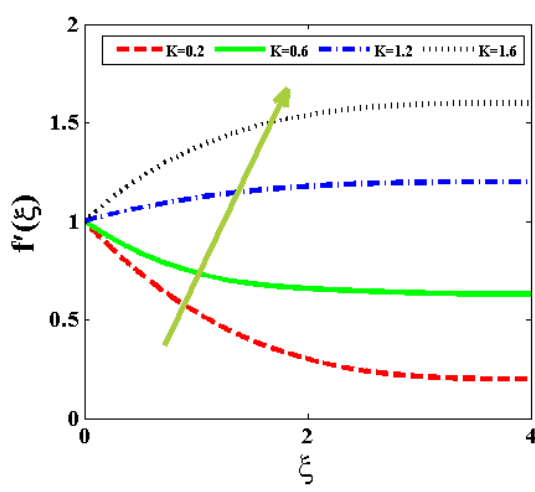
Figure 12. Outlines of 𝑓 ′ at diverse quantities of 𝐾 .